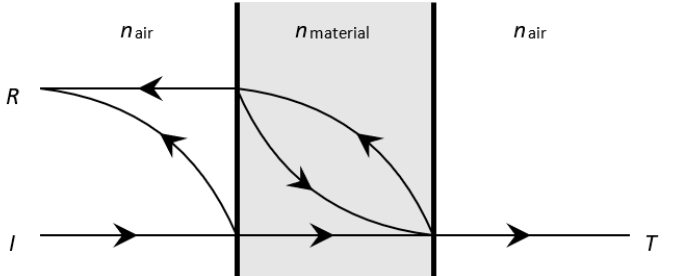
Figure 1. When an optical sample is structured with two parallel partially-reflective optical flats, the incident light (I) contributes to both the reflected (R) and transmitted (T) intensities. The light which is not immediately reflected (i.e., passes the first interface) can be internally reflected and ultimately add interference to either the reflected light or transmitted light. Note that absorbance is not explicitly depicted in this illustration but is assumed to affect both reflectance and transmittance.